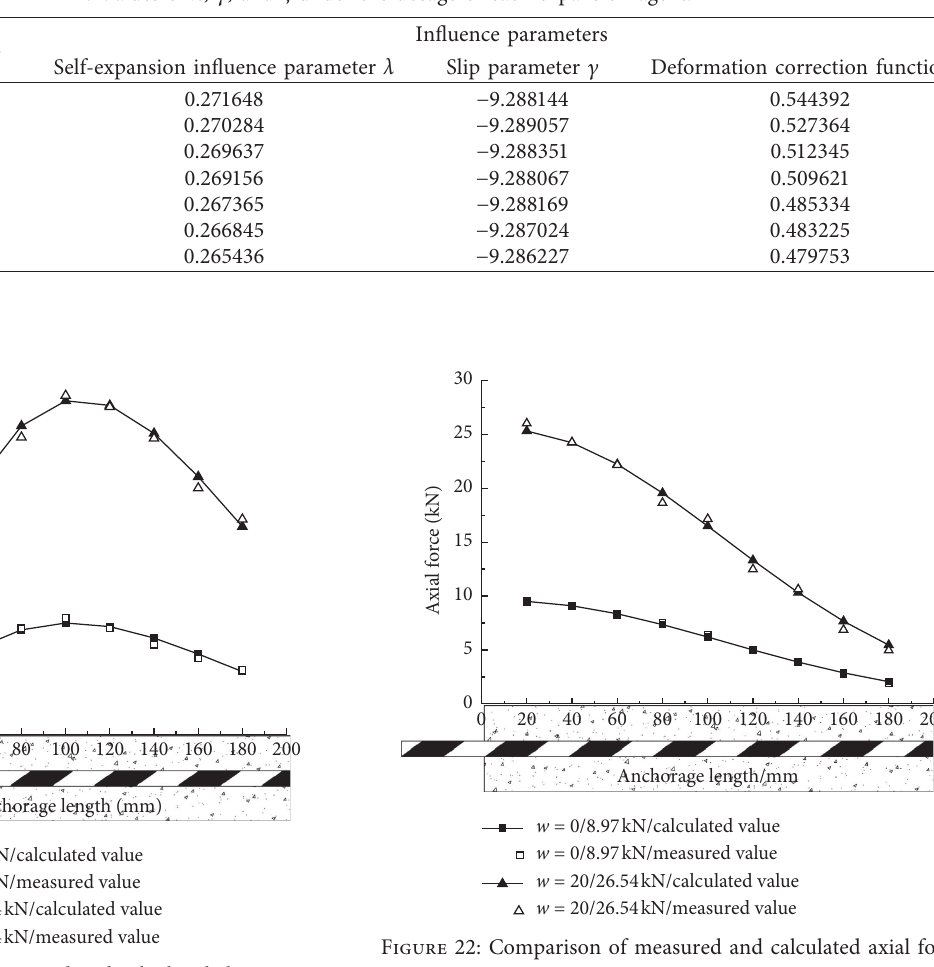
Table 4: Values of λ , c , and ξ under the dosage of each expansion agent.